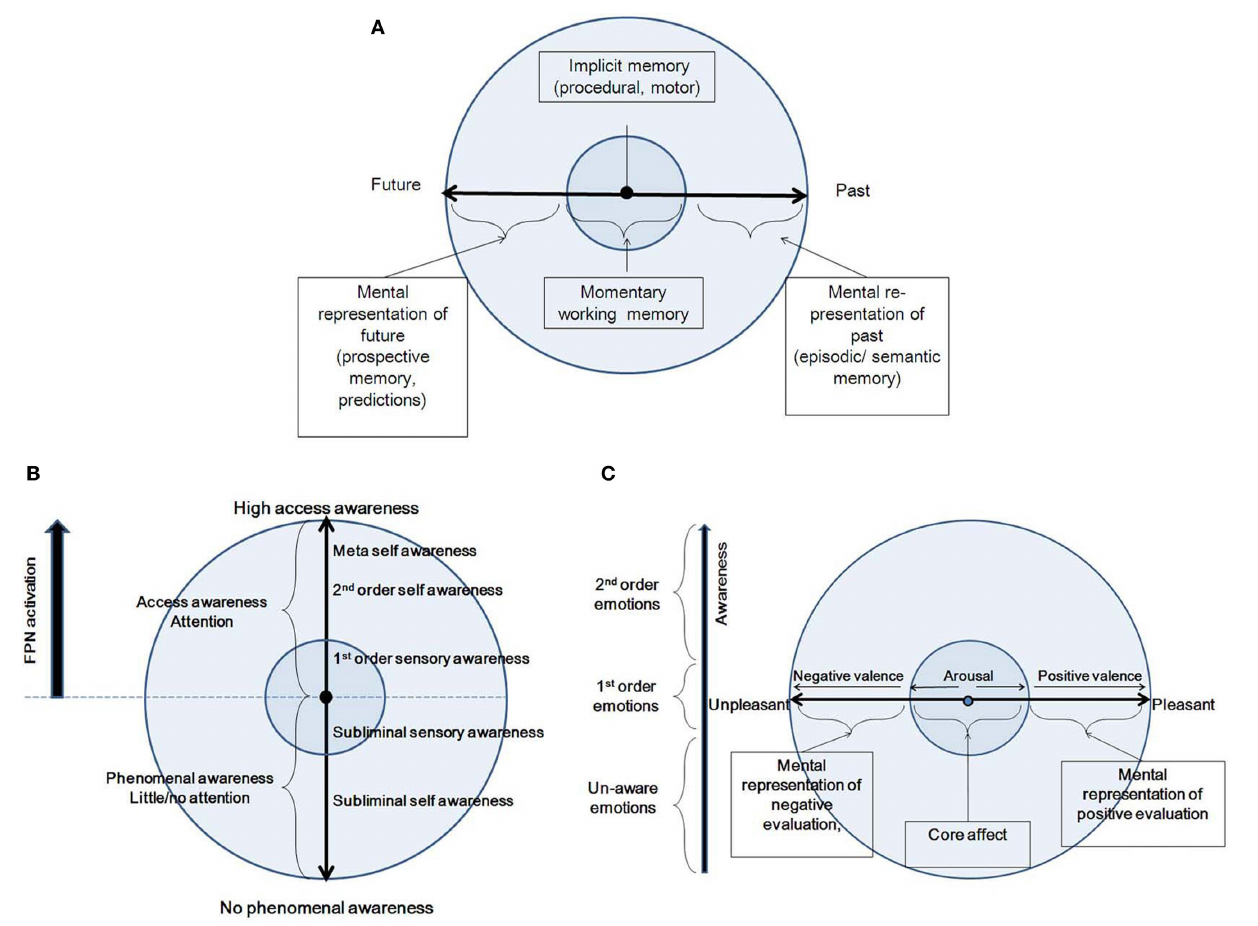
FIGURE 3 | A summary of the features of the three CSS dimensions: Time (A), Awareness (B) and Emotion (C).